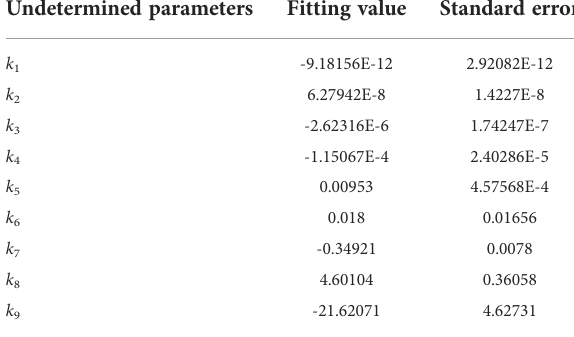
TABLE 2 The parameters in parameterized model of total ef fi